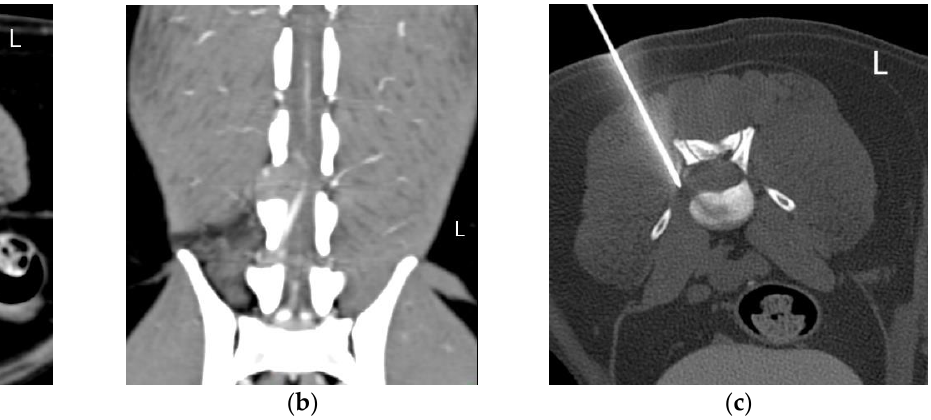
Figure 2. Case 3, 9-year-old Bodeguero andaluz with a L5-L6 right sided suspected peripheral nerve sheath tumor. ( a ) Transverse and ( b ) dorsal multiplanar reconstruction (MPR) of the lumbar spine (L5-L6) in a soft tissue window. There is an extramedullary intradural right-sided mass extending through the vertebral canal at the level of L5 and through the intervertebral foramen (IVF) at L5-L6. Note the muscle atrophy on the right epaxial muscles; ( c ) Transverse MPR at the level of the L5-L6 IVF in a bone window. There is evidence of a spinal needle in the mass in the IVF, introduced in a right dorsolateral approach.